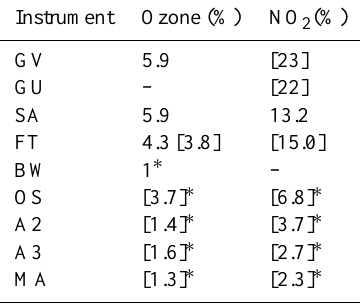
Table 2. Mean percent error of various measurements. Square brackets indicate errors in partial columns. Error sources are de- scribed in Sect. 2. Instrument abbreviations are summarized in Ta- ble 1. Note that for some instruments, error estimates include sys- tematic and random errors, while for others, only random errors are